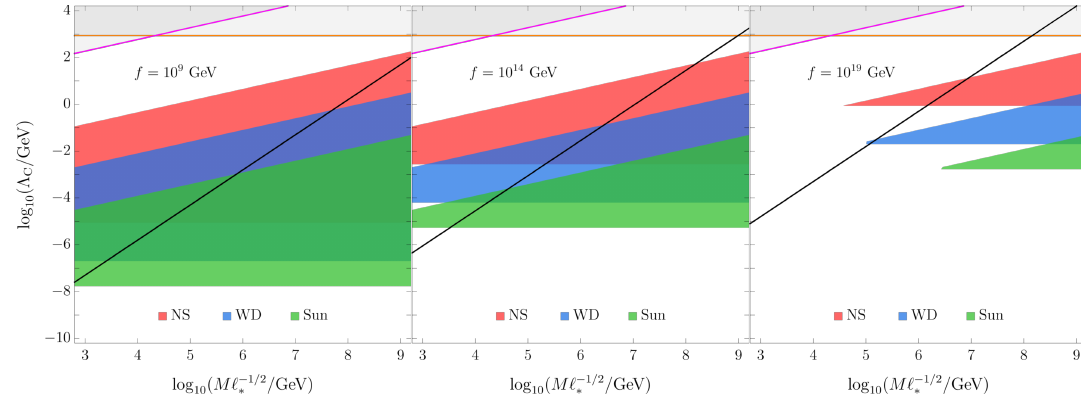
√ Figure 2 . ( M/ ‘ ∗ , Λ ) -regions excluded by the formation and escape of a non-QCD relaxion bubble C induced by neutron stars (red), white dwarfs (blue), and the Sun (green), in the case of shallow minima, δ 2 (cid:28) 1 or equivalently Λ ’ Λ , and for f = 10 9 , 10 14 , 10 19 GeV (left, middle, right panel, R C . 4 πv 2 (orange line) respectively). The grey, shaded region is excluded by the requirements Λ 2 C and ∆ h 2 < v 2 (magenta line), while the region of parameter space preferred by relaxation during inflation lies above the diagonal black line. Note that the latter line depends on a model-dependent period of dynamical evolution, which our constraints are independent of. The three lines are drawn taking ‘ ∗ = 1